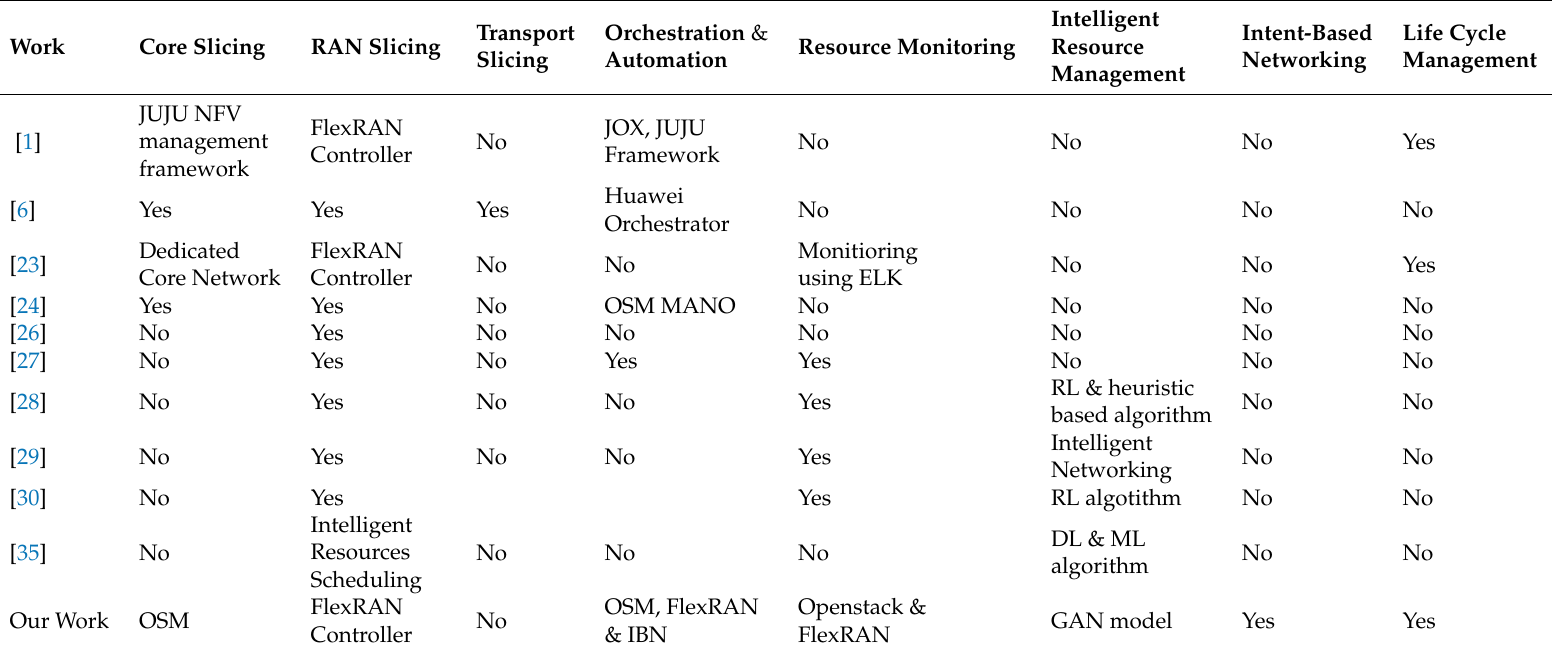
Table 1. Comparative analysis of proposed work with existing